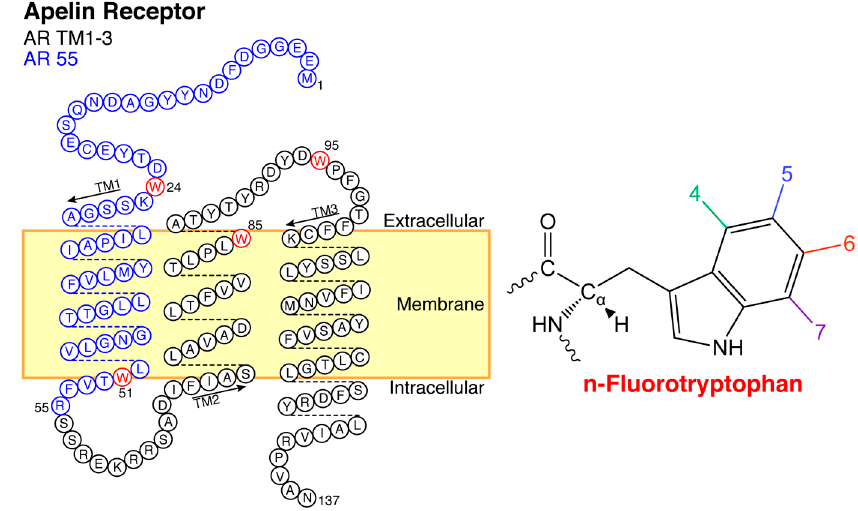
Figure 2. Biosynthetically 19 F-labelled apelin receptor segments used as model systems to probe ligand binding interactions. Blue indicates AR55, black indicates TM1-3, and red indicates a tryptophan, with each possible fluorinated substituent numbered as shown on the right.